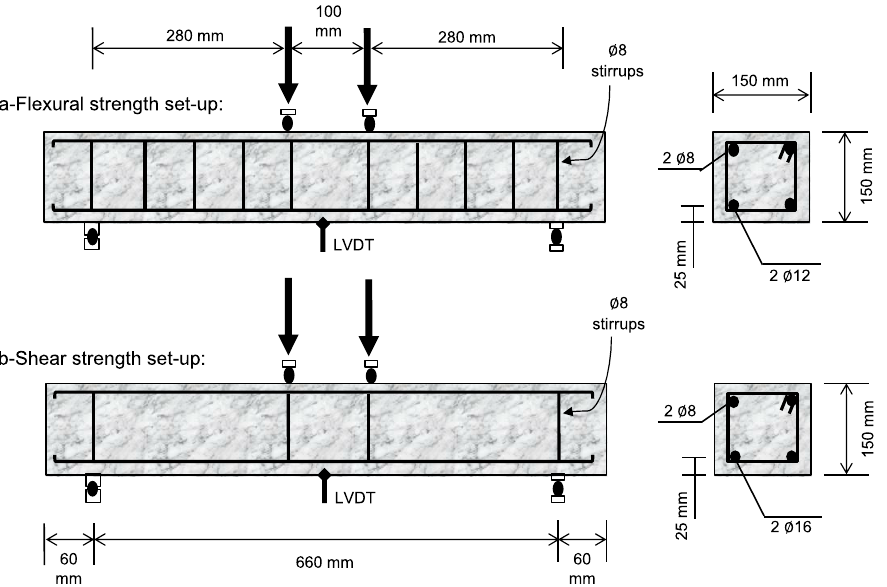
Figure 2. Configuration of RC beams for flexural and shear strength testing.